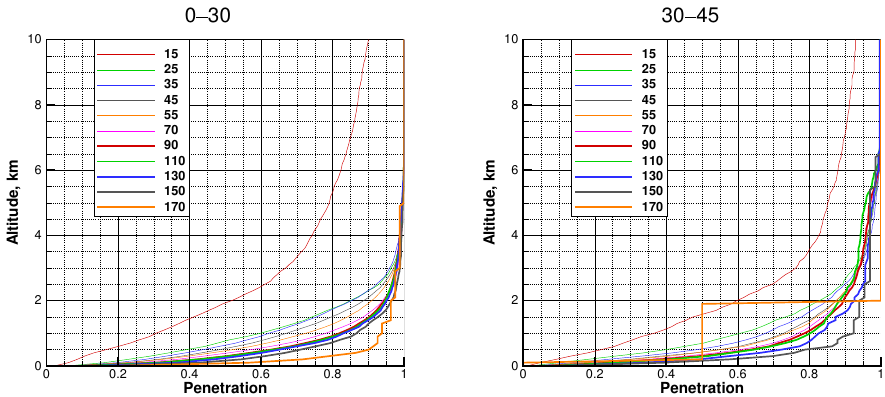
Figure 7. Similar to Figure 4. COSMIC-2, penetration.